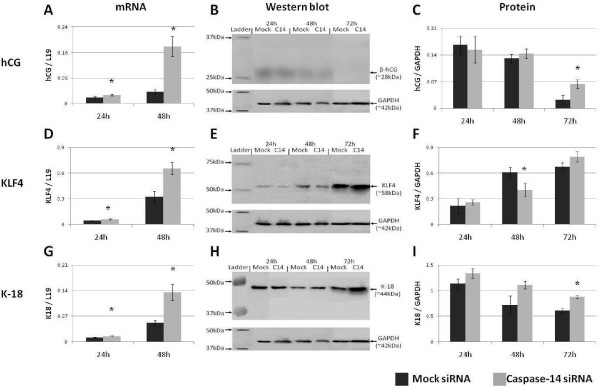
Caspase-14 modulates trophoblast gene expression. The effect of caspase-14 siRNA on the expression of (A-C) hCG, (D-F) KLF4 and (G-I) cytokeratin-18 in DMSO-treated BeWo cells. * = P < 0.05 versus Mock siRNA treated controls at the same time point.